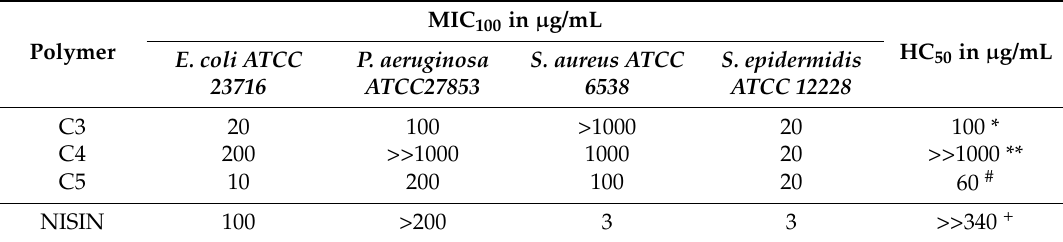
Table 5. Minimum inhibitory concentration (MIC) of the polymeric materials in bidistilled water and Mueller-Hinton broth (MHB) against bacteria (1–2 × 10 6 cfu/mL) (MIC 100 : complete growth